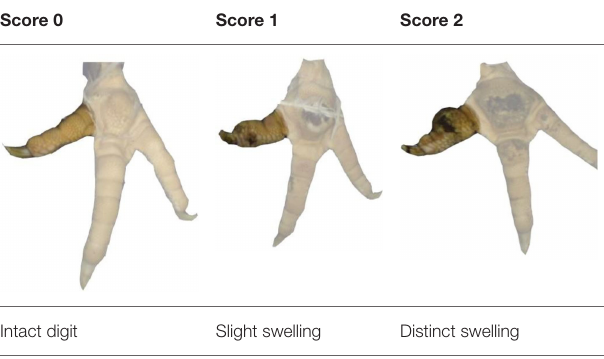
TABLE 3 | Scoring system for the digital pads: Grade of swelling on the digital